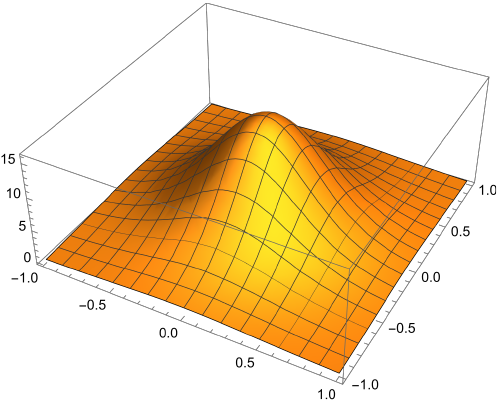
Figure 2 . The density of the basic (1,1) fluid Hopfion as a function of x and y for t = 0 , z = 0